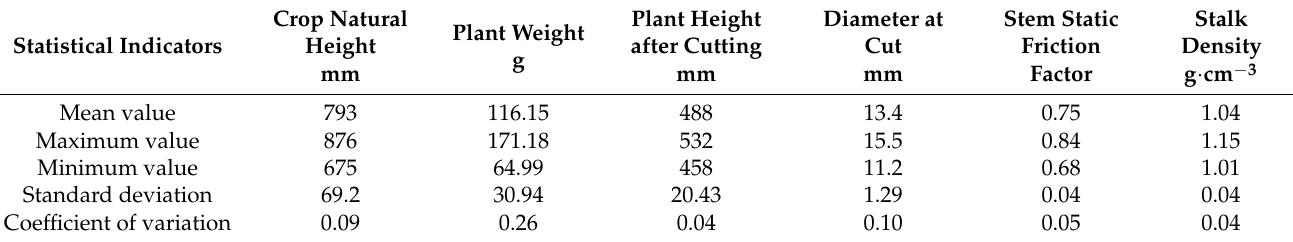
Table 3. Basic physical parameters of rape